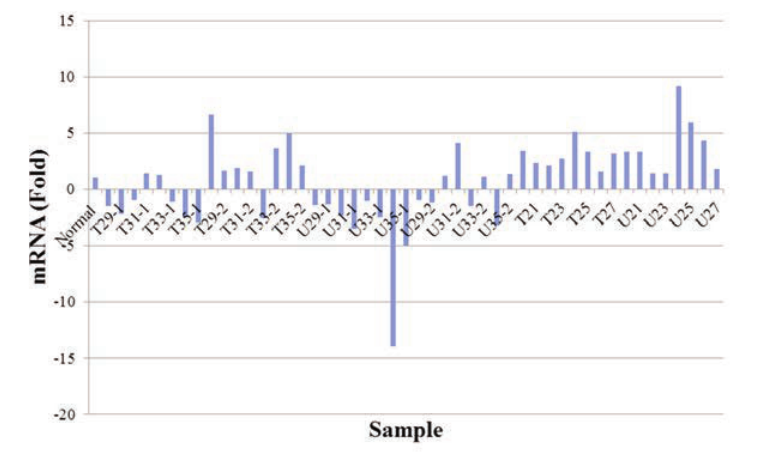
Figure 3. Gene expression of Interferon T= treatment) by realtime PCR.